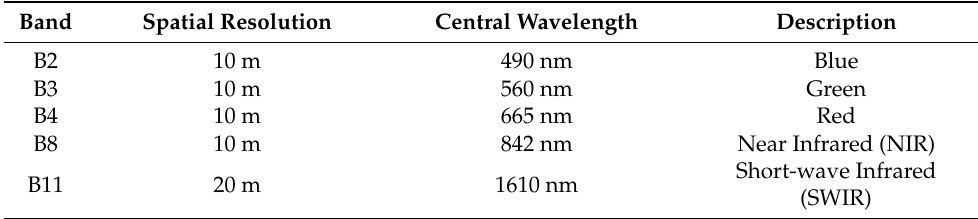
Table 2. Characteristics of the S2 bands